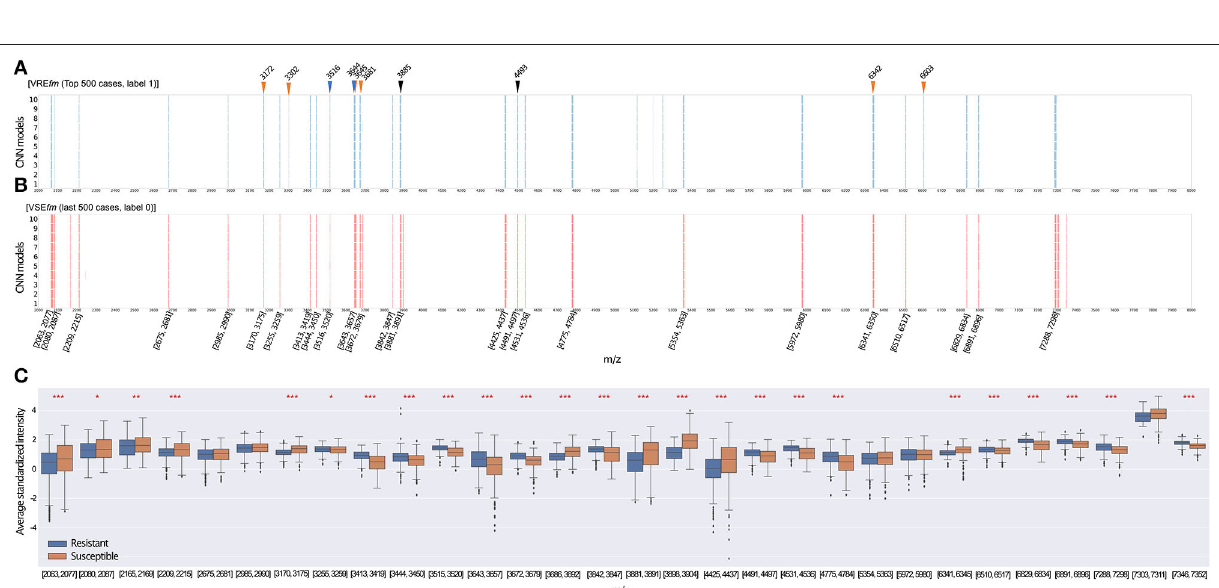
FIGURE 5 | Feature selection is based on the Score-CAM. Each row of m/z peaks represents the important features with top 1% weights in the different models. The important features of our CNN models for the classification of vancomycin-resistant E. faecium (VRE fm ) (A) and vancomycin-susceptible E. faecium (VSE fm ) (B) in the last and top 500 testing cases, respectively. Rectangles represent the important features of m/z ranges selected by at least 8 independent CNN models using Score-CAM. Triangles indicate that the important markers at m/z signals for discrimination of VRE fm strain have been identified in the literature. Blue is identified by Wei et al. (2014), black is identified by Lasch et al. (2014), and orange is identified by Wang et al. (2020b). (C) The intensity distribution of informative features with the normalized intensities of 500 resistant and 500 susceptible isolates. The star (*) indicates a statistical difference in the feature intensities between resistant and susceptible isolates. Wilcoxon-rank sum test was applied to test the difference between the two groups. * q -value < 0.05, ** q -value < 0.01, ***, q- value <